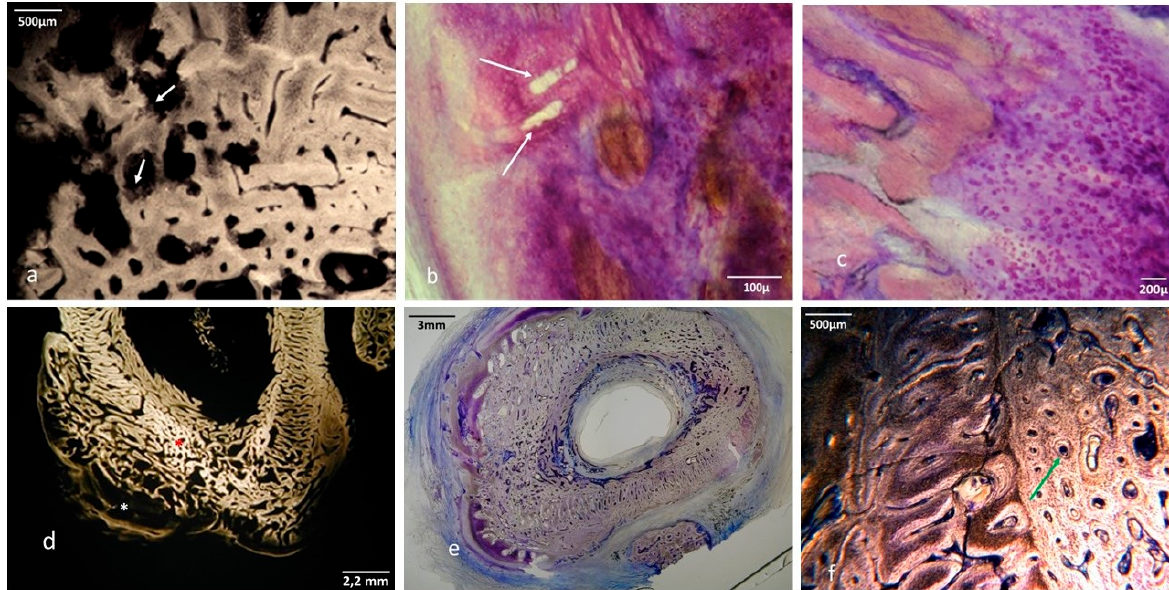
Figure 8. ( a ) microradiograph of the first level: the bone fragment shows numerous erosion cavities (white arrows). ( b ) histological findings at 2nd level. Three distinct areas are evident: fibrous tissue, woven bone, and cartilage. The white arrows point to wide immature vascular cavities within the cartilage next to woven bone (toluidine blue). ( c ) histological findings at 3rd level: the microphotograph shows a cartilage area densely populated with hypertrophic chondrocytes surrounded by an evident capsule. These islands are adjacent to the newly-laid-down bone (toluidine blu). ( d ) microradiograph of the 4th level: the photo shows an entire circular structure presenting a rough stratification. The red asterisk indicates more central mineralized (radio-opaque) areas with many visible osteons; the white asterisk shows peripheric cartilage impressions. ( e ) Histological section of the 4th level: peripherally are visible cartilaginous islands surrounding primary bone (violet-stained) (toluidine blue). ( f ) microphotograph of the 4th level: In the internal mineralized areas, secondary voluminous osteons are evident. (Green arrow) (toluidine blu).